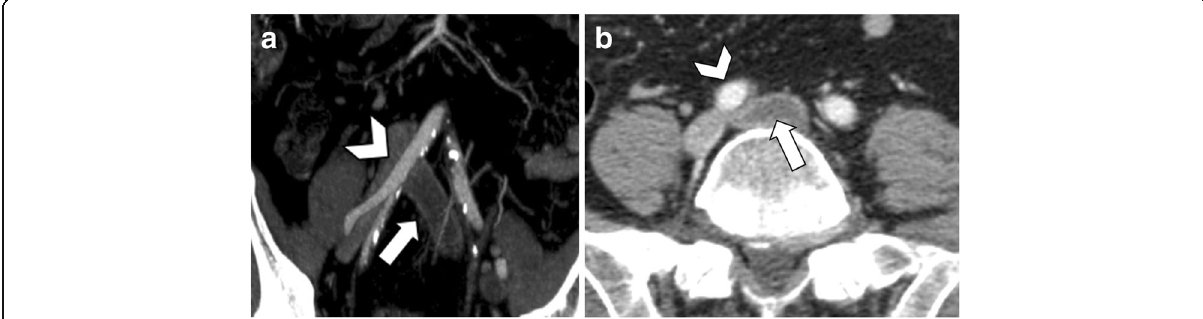
Fig. 9 An 85-year-old man with May-Thurner syndrome. Coronal ( a ) and axial ( b ) contrast-enhanced CT images show thrombosed left common iliac vein (arrows) compressed between the right common iliac artery (arrowheads) and fifth lumbar